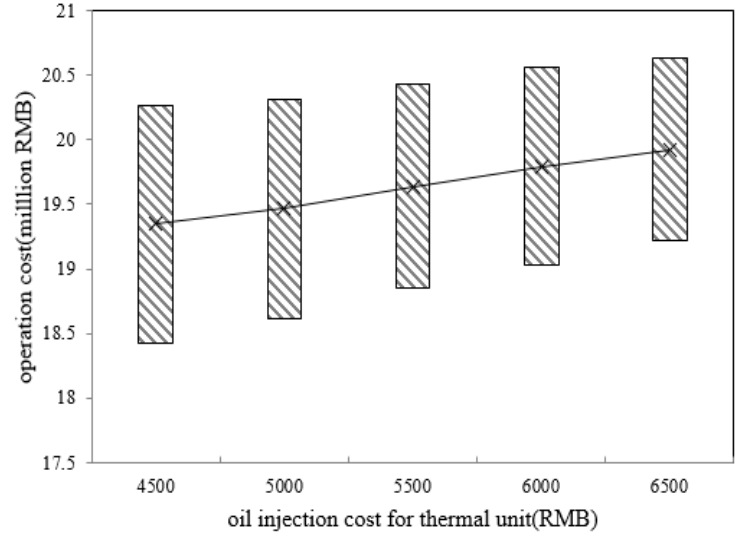
Figure 8. Optimal operation cost interval under different oil injection costs.